Question: In one sentence, what is this figure communicating?
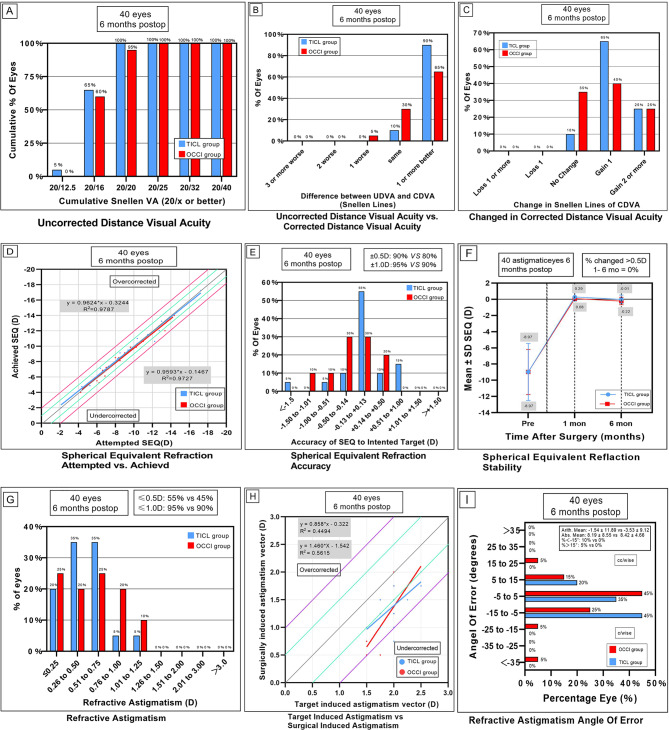
Answer: Visual and refractive outcomes after TICL implantation and ICL combined with OCCI. ( A ) Postoperative uncorrected distance visual acuity (UDVA) distribution (≥20/20). ( B ) Proportion of eyes with postoperative UDVA improved by one line or more compared with preoperative corrected distance visual acuity (CDVA). ( C ) Change in CDVA from preoperative to 6 months postoperatively. ( D ) Linear regression analysis of attempted versus achieved spherical equivalent (SEQ). ( E ) Refractive accuracy: percentage of eyes with SEQ within ±0.50 D and ±1.00 D. ( F ) Stability of SEQ at 1 and 6 months postoperatively. ( G ) Residual refractive astigmatism within 0.50 D and 1.00 D. ( H ) Linear regression of target‑induced astigmatism (TIA) versus surgically induced astigmatism (SIA). ( I ) Distribution of angle of error (AE) at 6 months. D = diopters; logMAR = logarithm of the minimum angle of resolution